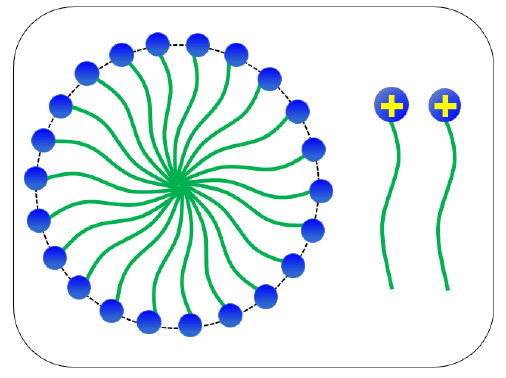
Figure 1. Conventional single-chain VES.